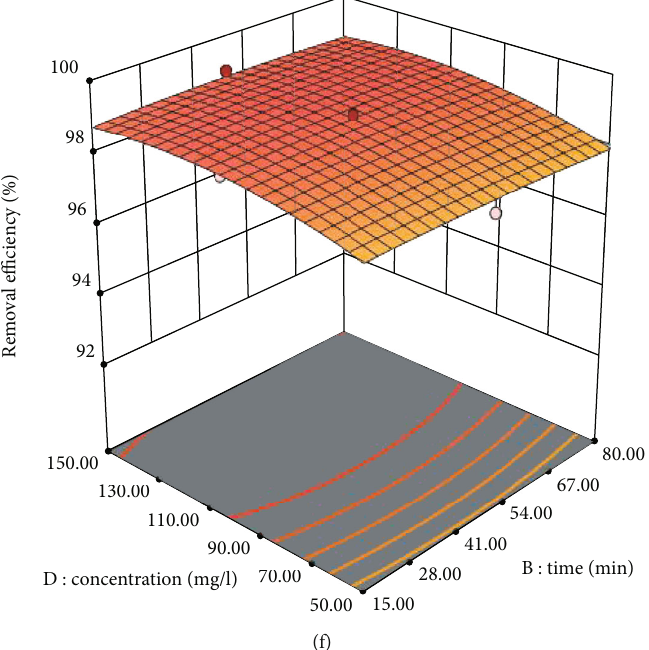
Figure 7: 3D surface plots of the interactive e ff ect of CEX on Fe